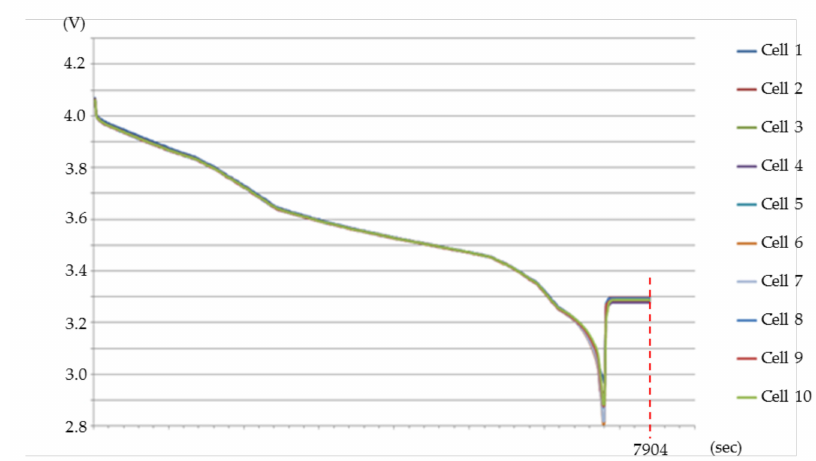
Figure 9. Discharge curve measured by LTC6803.